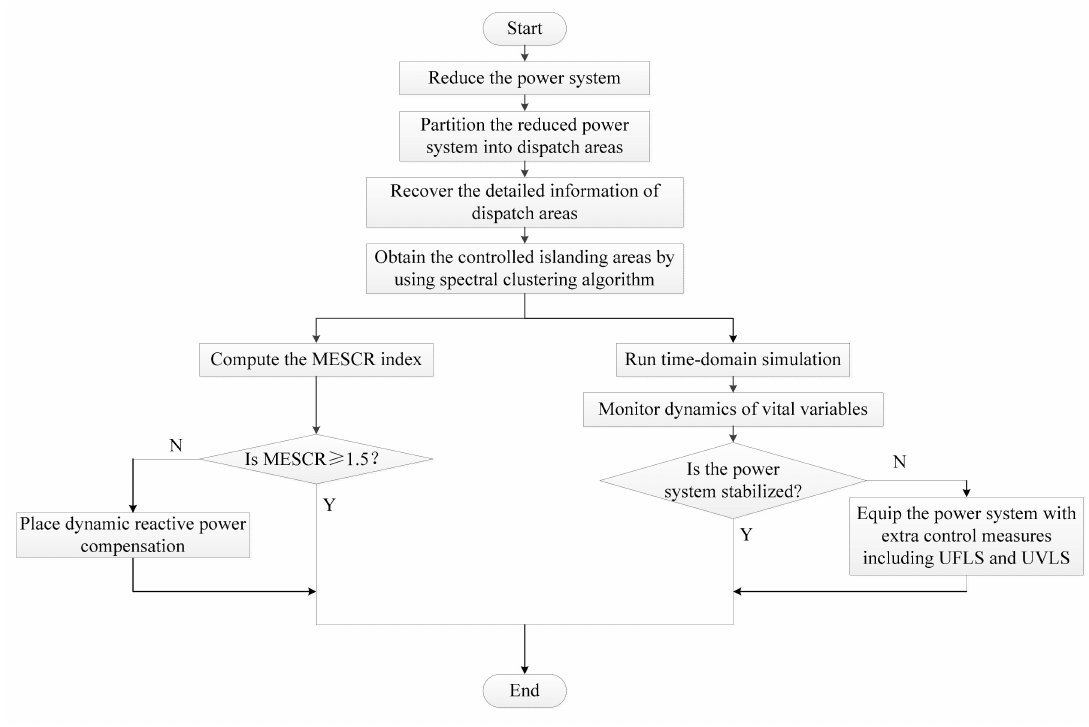
Figure 5. Flowchart of the controlled islanding